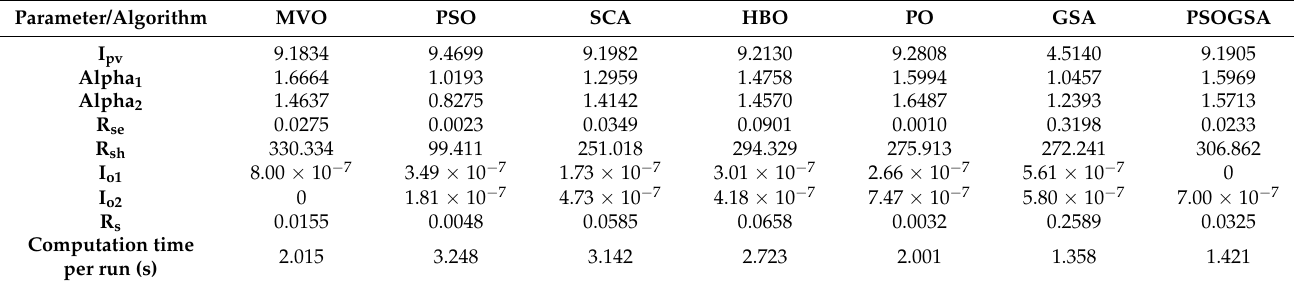
Table 6. The monocrystalline MDDM parameter estimation